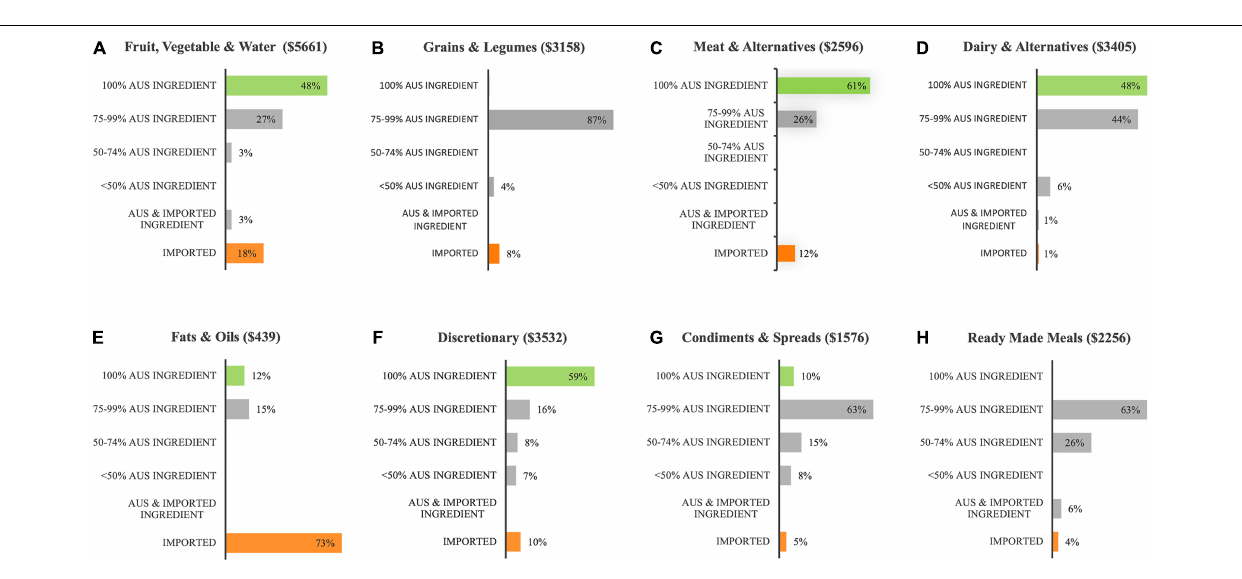
apple, all canned legumes, rice and split green peas, fish and tofu, Asian sauces, dry gravy, seasoning, soup mixes, and two- minute noodles. Also of note, processed pork products (ham and bacon) from the discretionary group contained only minimal Australian